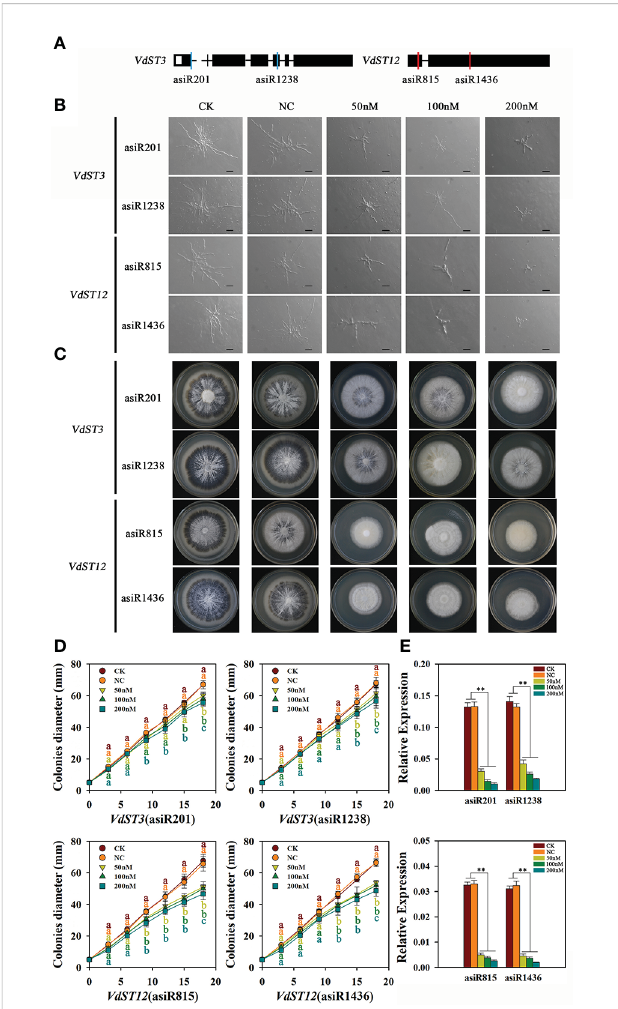
FIGURE 5 Effect of asiRNAs targeting VdST3 and VdST12 on fungal hyphae and colony morphology. (A) The target sites of asiRNAs in VdST3 and VdST12 . Black boxes indicated exons, and red and blue lines represented the target sits. (B) Effect of asiRNAs targeting VdST3 or VdST12 on hyphal growth. The Vd991 strain was incubated in Czapek liquid medium containing asiRNA at different concentrations (0, 50, 100 or 200 nM) before inoculating on PDA medium. Wild-type Vd991 was